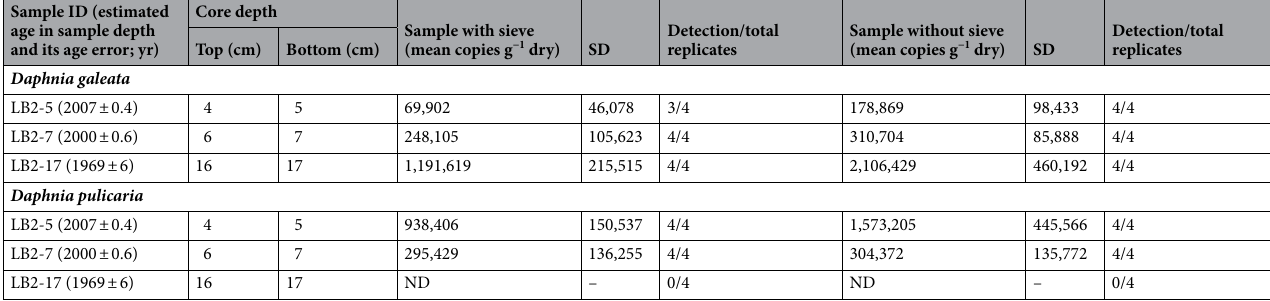
Table 2. 12S rRNA gene copy numbers (copies g −1 of dry sediment) for Daphnia galeata and Daphnia pulicaria in sediment samples with and without